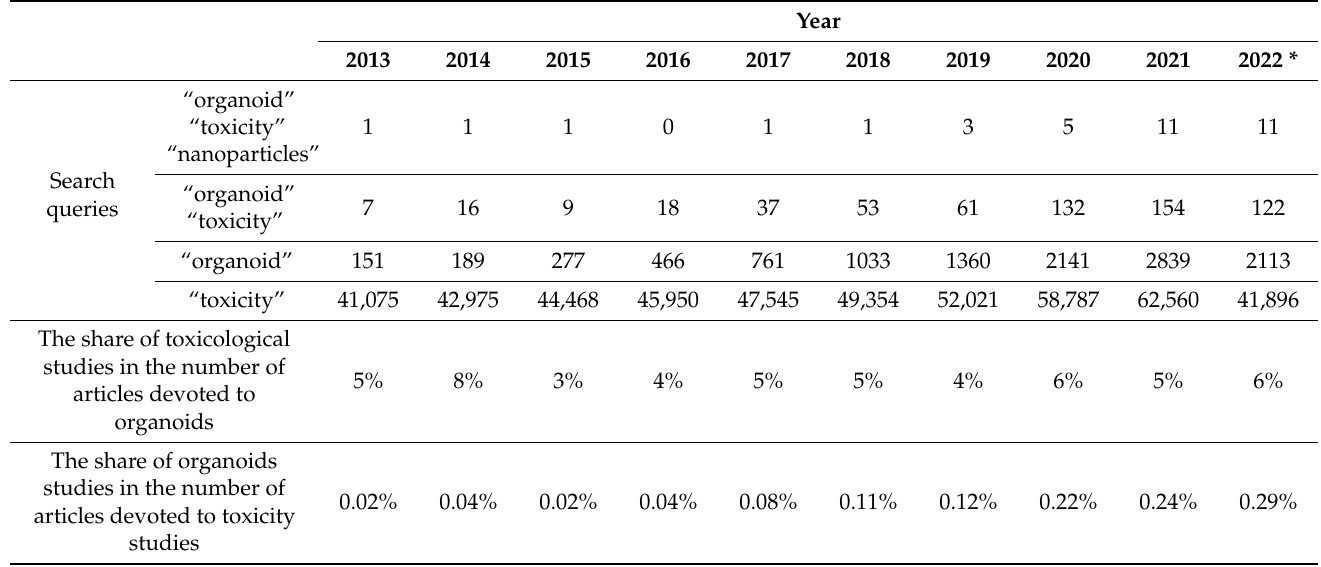
Table 1. Distribution of articles by search queries related to toxicology and